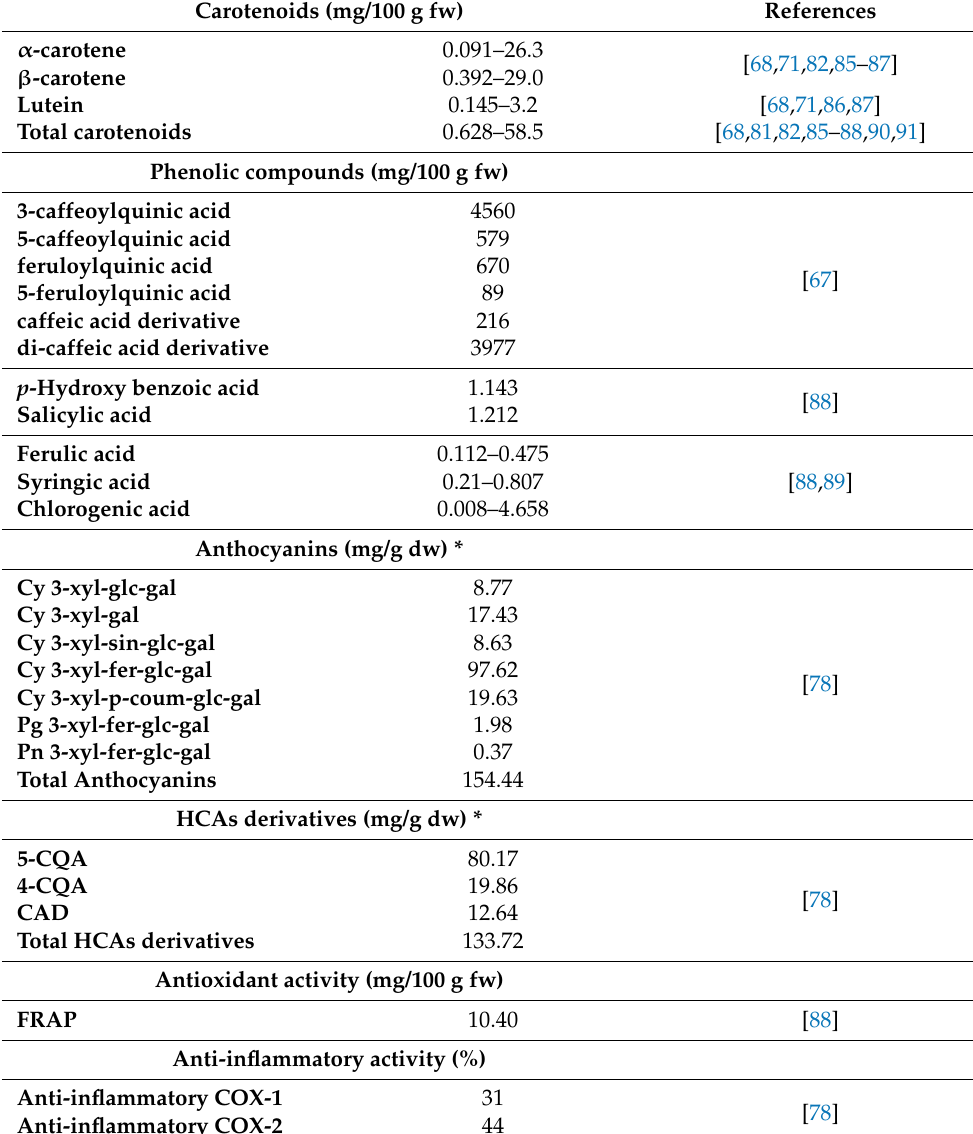
Table 2. Carotenoids, phenolic compounds, antioxidant and anti-inflammatory activities of Daucus carota L.